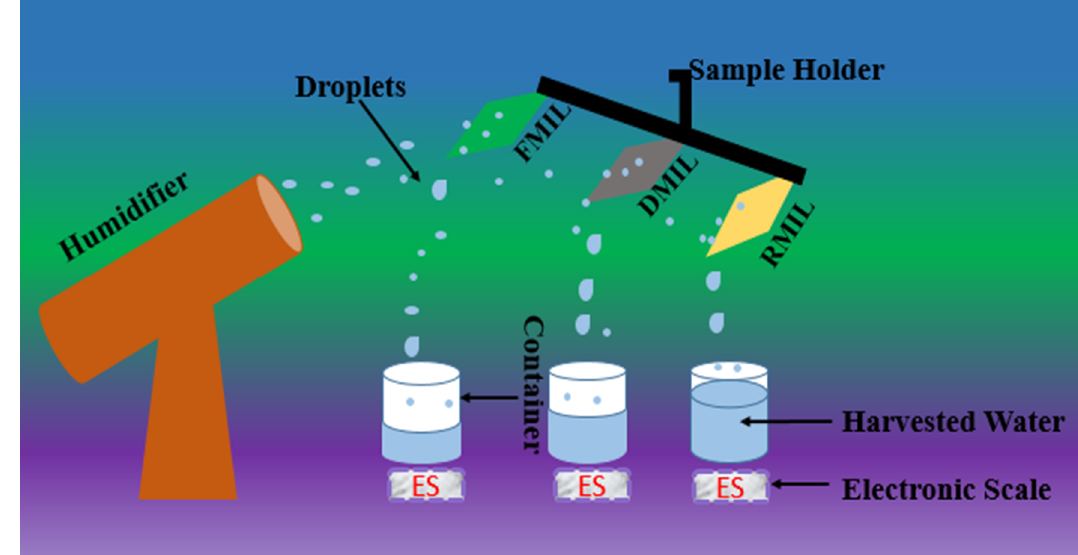
Figure 3. A schematic illustration of water collection experimental setup.